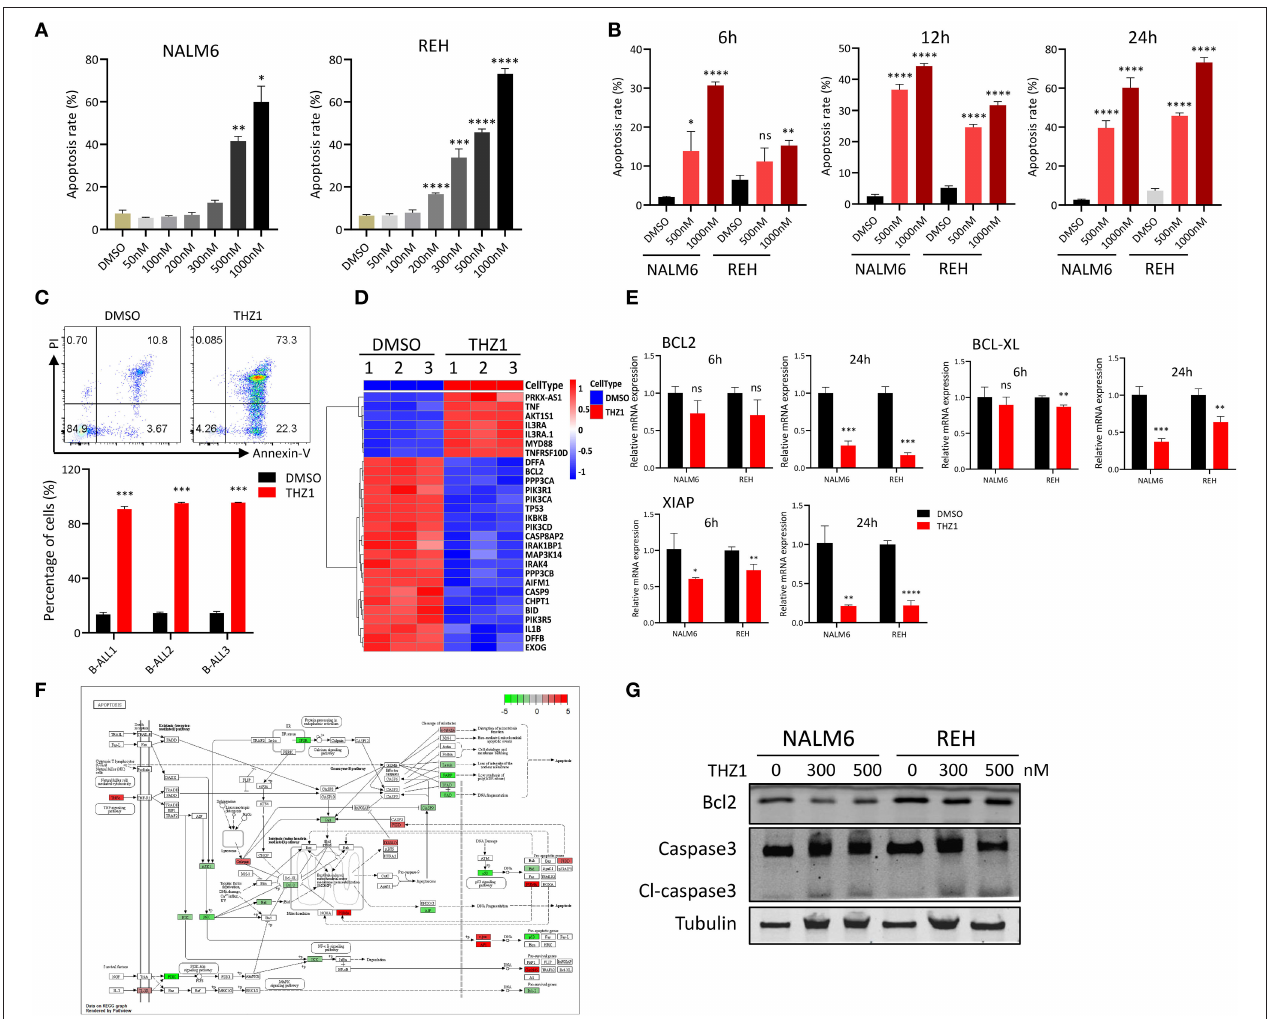
FIGURE 2 | THZ1 induces apoptosis in B-ALL cells. (A) Cell apoptosis of NALM6 and REH cells was analyzed by flow cytometry using Annexin V and PI double staining after treatment with different concentrations of THZ1. (B) Cell apoptosis of NALM6 and REH cells was analyzed by flow cytometry after treatment with THZ1 for 6, 12, and 24h. (C) Cell apoptosis of primary B-ALL cells was analyzed by flow cytometry using Annexin V and PI double staining after treatment with THZ1 for 24h. (D) Heatmap of cell apoptosis-related genes in THZ1- and DMSO-treated NALM6 cells. (E) The mRNA expression of BCL2, BCL-XL, and XIAP was measured by qRT-PCR in THZ1- and DMSO-treated B-ALL cells. (F) Pathview analysis of down and upregulated cell apoptosis-related genes in THZ1-treated B-ALL cells. (G) Anti-apoptotic BCL2 and apoptotic Caspase 3 proteins of B-ALL cells were detected by Western blot. B-ALL cells were treated with THZ1 for 24h. Values were shown as mean ± SEM. * p < 0.05, ** p < 0.01, *** p < 0.001, and **** p <